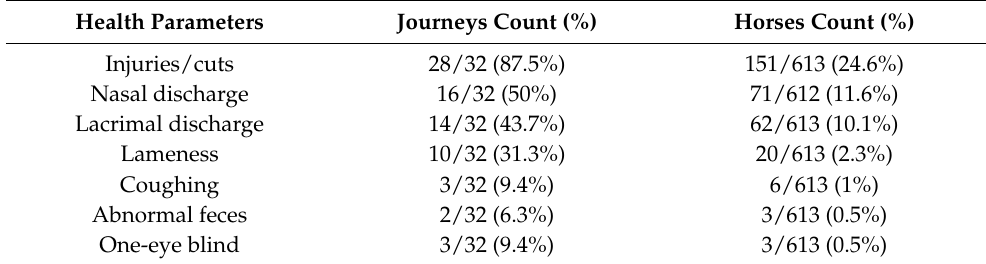
Figure 2. Two handled horses displaying injuries after being transported to the slaughterhouse: ( a ) example of an injury at the level of the orbital socket; ( b ) example of an injury at the level of lips. Table 8. Prevalence of health parameters for the handled horses (n = 613) and 32 journeys towards slaughterhouses in Italy.